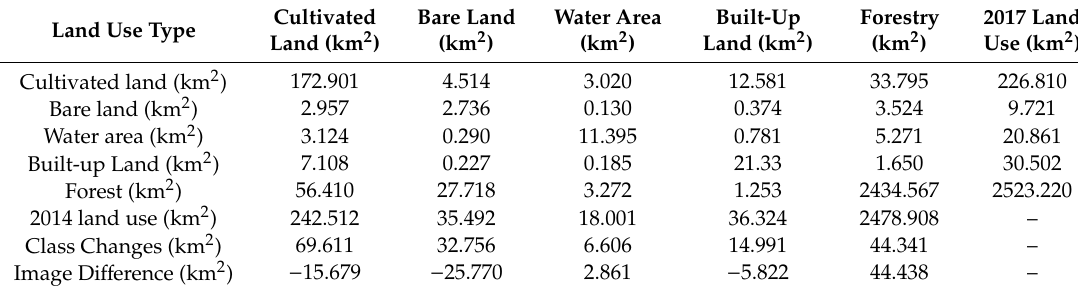
Table 1. Matrix of land use change during 2014–2017 (km 2 ).